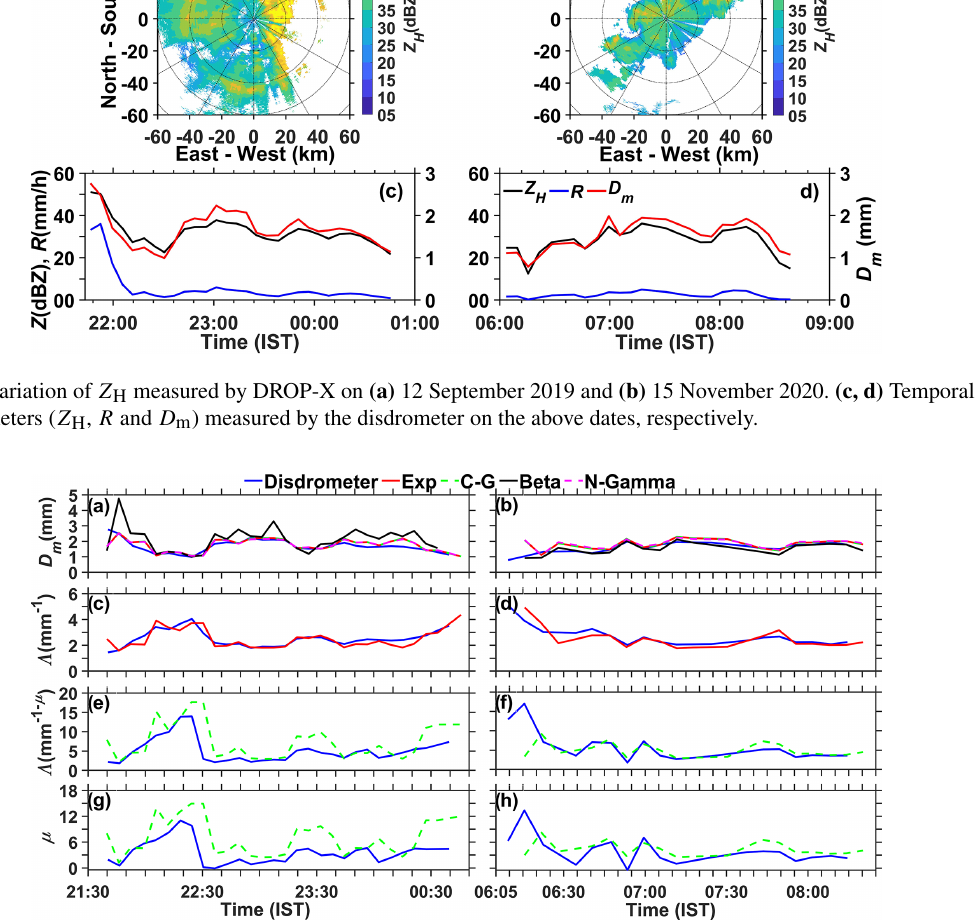
Figure 7. Comparison of (a, b) D m , (c, d) (cid:51) by assuming an exponential distribution, (e, f) (cid:51) by assuming a gamma distribution, and (g, h) µ by assuming a gamma distribution on 12 September 2019 and 15 November 2020, respectively, with disdrometer-derived